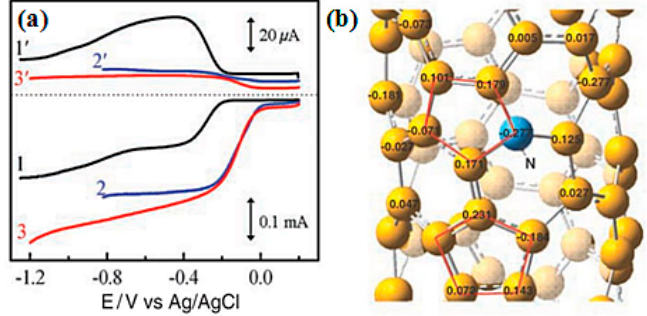
Figure 6. ( a ) Rotating ring-disk electrode (RRDE) voltammograms and the corresponding amperometric responses for oxygen reduction in air-saturated 0.1 M KOH at the CNT/GC (curves 1 and 1 ′ ), Pt-C/GC (curves 2 and 2 ′ ), and N-doped CNT/GC (curves 3 and 3 ′ ) electrodes at a scan rate of 10 mV/s. The electrode rotation rate was 1400 rpm, and the Pt ring electrode was poised at 0.5 V; ( b ) Calculated charge density distribution of the N-doped CNTs. (From [56]. Reprinted with permission from The American Association for the Advancement of Science).